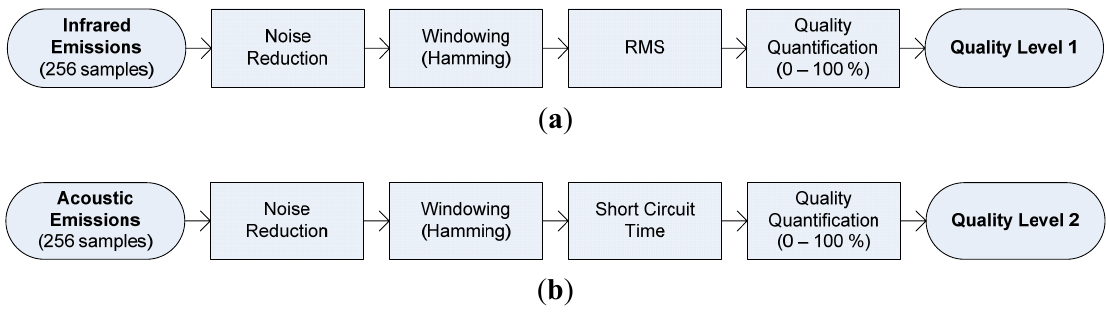
Figure 7. Quality level parameters, ( a ) From infrared signal, ( b ) From acoustical signal, ( c ) welding trial with induced